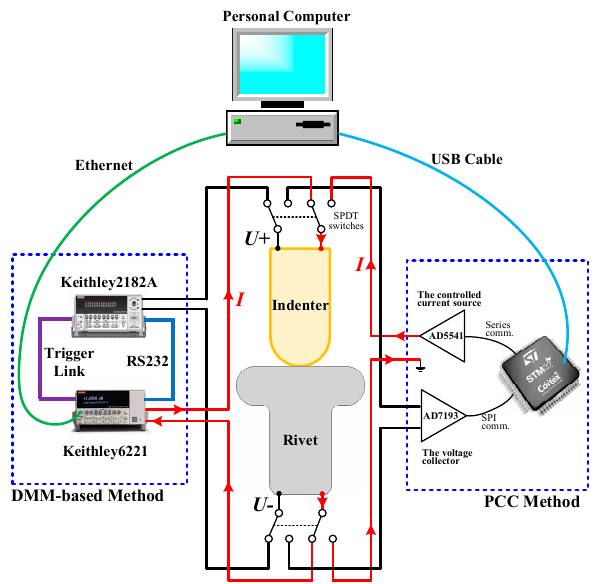
Figure 8. Experimental circuits for the DMM-based method and PCC method. Start